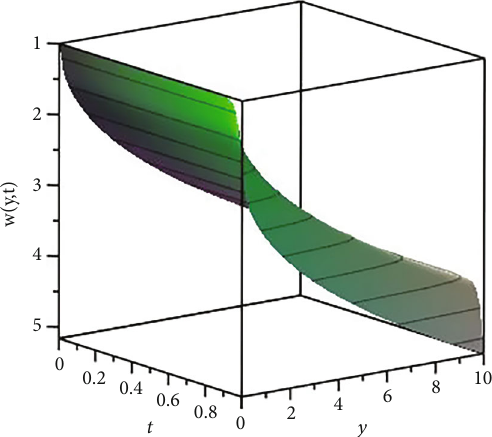
Figure 8: 3D plot of (30) for α = 10